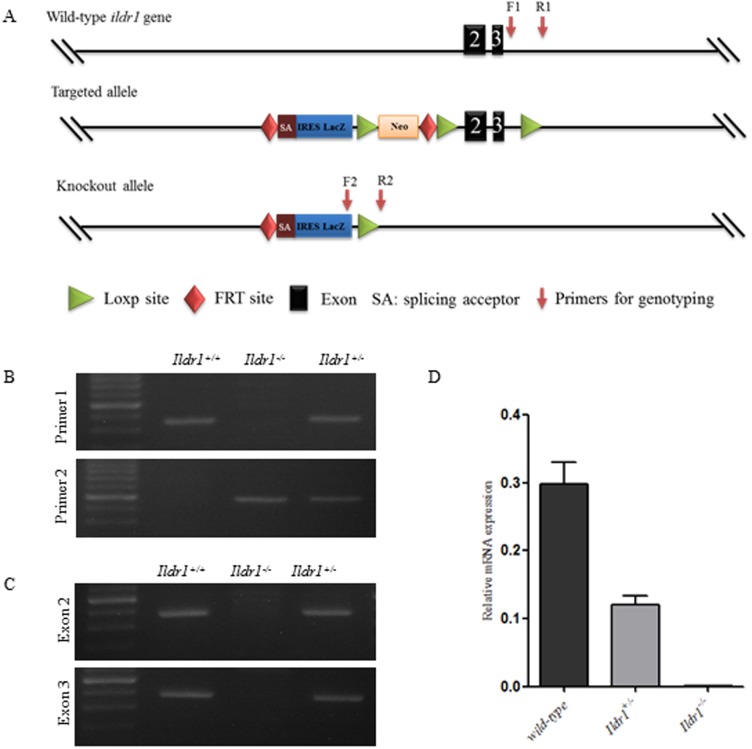
Generation of the Ildr1 knockout allele and the Ildr1−/− mouse.(A) The structure of the wild-type gene and the general features of the targeted allele and knockout allele. Primer pairs for genotyping were indicated by red arrows. (B) Mouse genotyping using RT-PCR. Primer 1 and primer 2 were used to distinguish the wild type allele and knockout allele respectively. (C) RT-PCR shows the deletion of exon 2 and exon 3 in Ildr1−/− mouse. (D) qRT-PCR shows the absence of ildr1 mRNA.